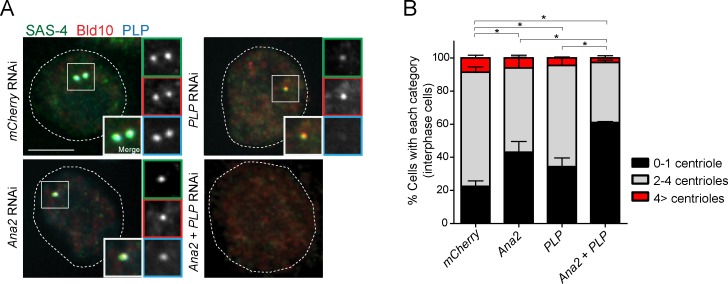
Counting of the centriole number in interphase cells.(A) Images of interphase D. Mel cells after depletion of PLP and Ana2 by RNAi, used for centriole counting in Figure 6. Cells were immunostained with anti-Bld10 (red), SAS-4 (another centriole marker, green), and PLP (cyan) antibodies. Scale bar, 5 μm. (B) Quantification of centriole number per cell (N > 50). Data are the average of three experiments ± s.d (*p<0.05, Mann-Whitney U test performed for the 0–1 centriole category).10.7554/eLife.41418.021Figure 6—figure supplement 1—source data 1.The source data to plot the graph in Figure 6—figure supplement 1B.